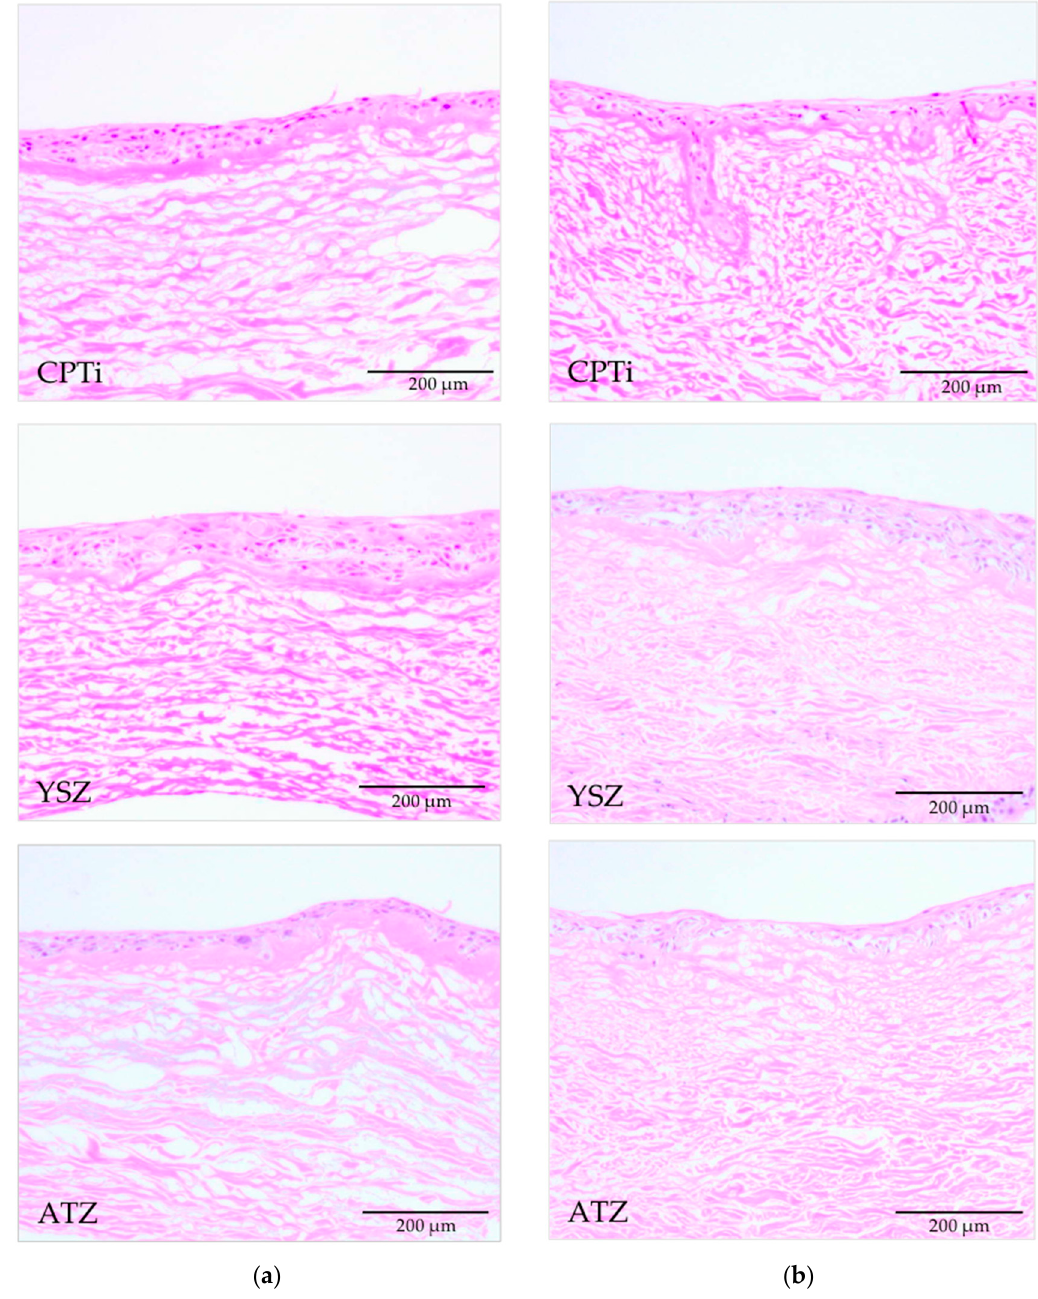
Figure 7. Histological section of the corresponding punched tissue of the models ( a ) from the UV-treated and ( b ) from the nontreated groups (20× magnification).